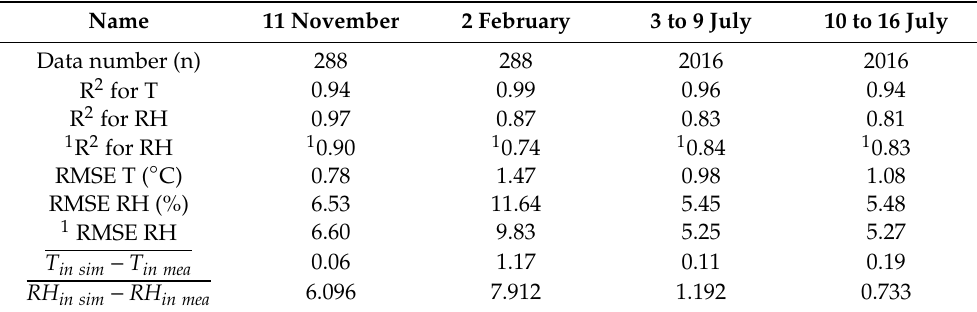
Table 2. Comparative analysis of the results obtained through the proposed humidity model and those obtained from a humidity model that includes (i) a di ff erent method of calculating evapotranspiration. Reproduced with permission from [32]. American Society of Agricultural and Biological Engineers, 1985, and (ii) an equation for condensation. Reproduced with permission from [41]. International Society for Horticultural Science,